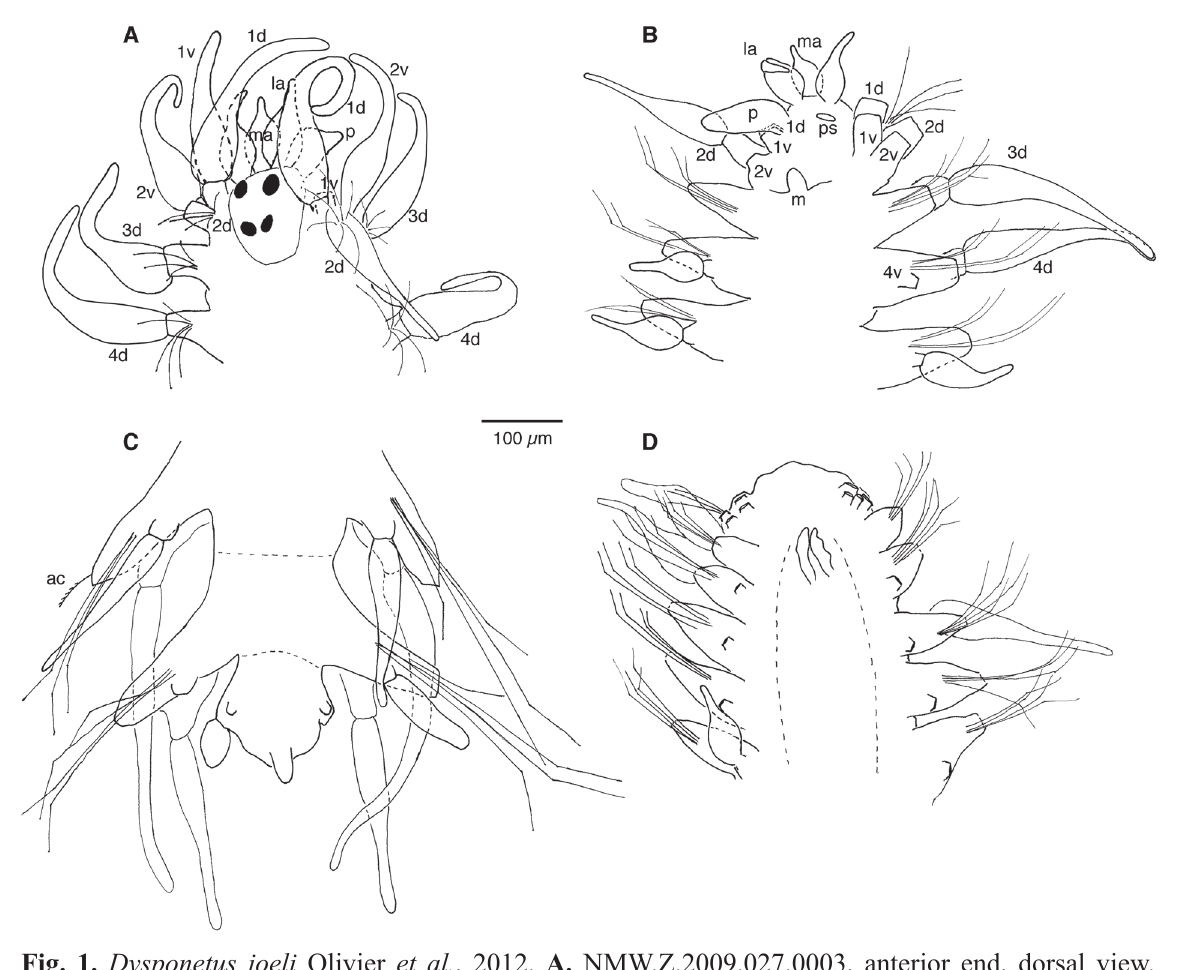
Fig. 1. Dysponetus joeli Olivier et al. , 2012. A. NMW.Z.2009.027.0003, anterior end, dorsal view. B. NMW.Z.2009.027.0004, anterior end, ventral view. C. NMW.Z.2009.027.0003, posterior end, ventral view. D. Holotype (MNHN POLY TYPE 1533), anterior end, ventral view. Only a few chaetae drawn in each case for clarity. – ac = accessory chaeta, d = dorsal (cirrus/cirrophore), la = lateral antenna, ma = median antenna, m = mouth appendage, p = palp, ps = palp scar, v = ventral (cirrus/cirrophore); numbers indicate the